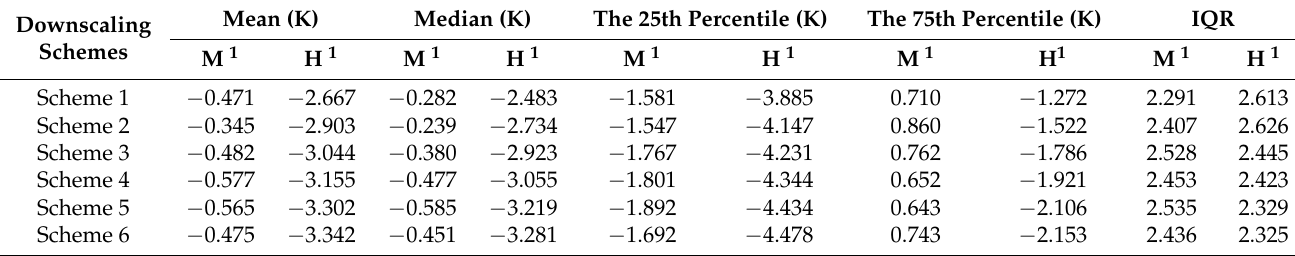
Figure 13. LST error distribution histograms of the MFGWML and HUTS models for the six downscaling schemes: ( a1 , a2 , b1 , b2 , c1 , c2 , d1 , d2 , e1 , e2 , f1 , f2 ). Plots ( a1 , a2 ) represent the LST error distribution histograms for Scheme 1, which corresponds to the MFGWML and HUTS models, respectively. The remainder of the plots are named in the same manner. Table 11. Statistical indicators of LST error distribution in MFGWML and HUTS for six downscaling schemes performed around the central urban